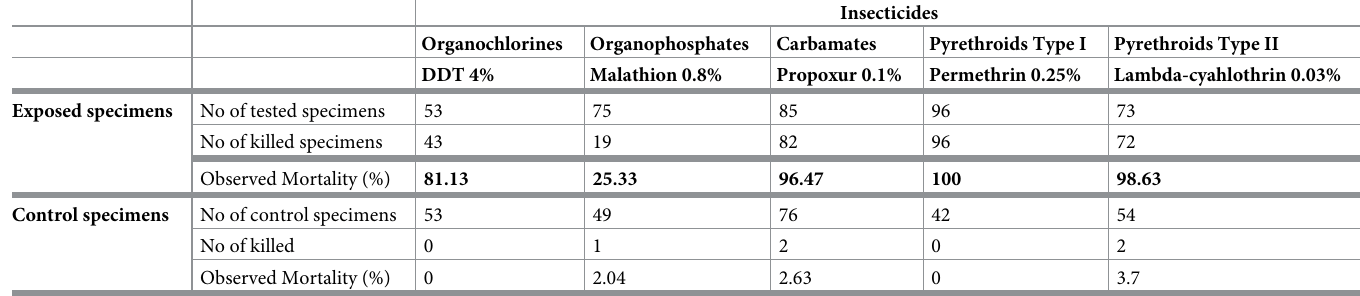
Table 1. Mortality rate following bioassays using DDT 4% (organochlorines), Malathion 0.8% (organophosphates), Propoxur 0.1% (carbamates) and Permethrin 0.25% and Lambda-cyhalothrin 0.03% (pyrethroids).